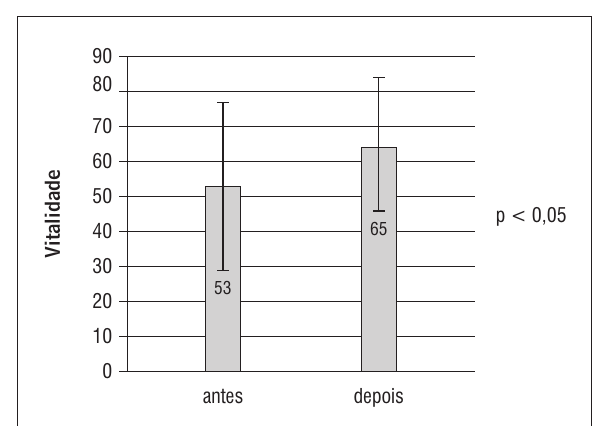
Figura 5 - Média e desvio-padrão da vitalidade dos pacientes antes e depois do protocolo fisioterapêutico (n = 27; p < 0,05)